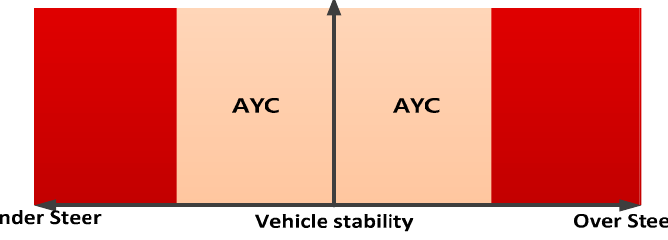
Figure 6. Operating region of acitve yaw rate control. Table 1. Cornering stability Index.